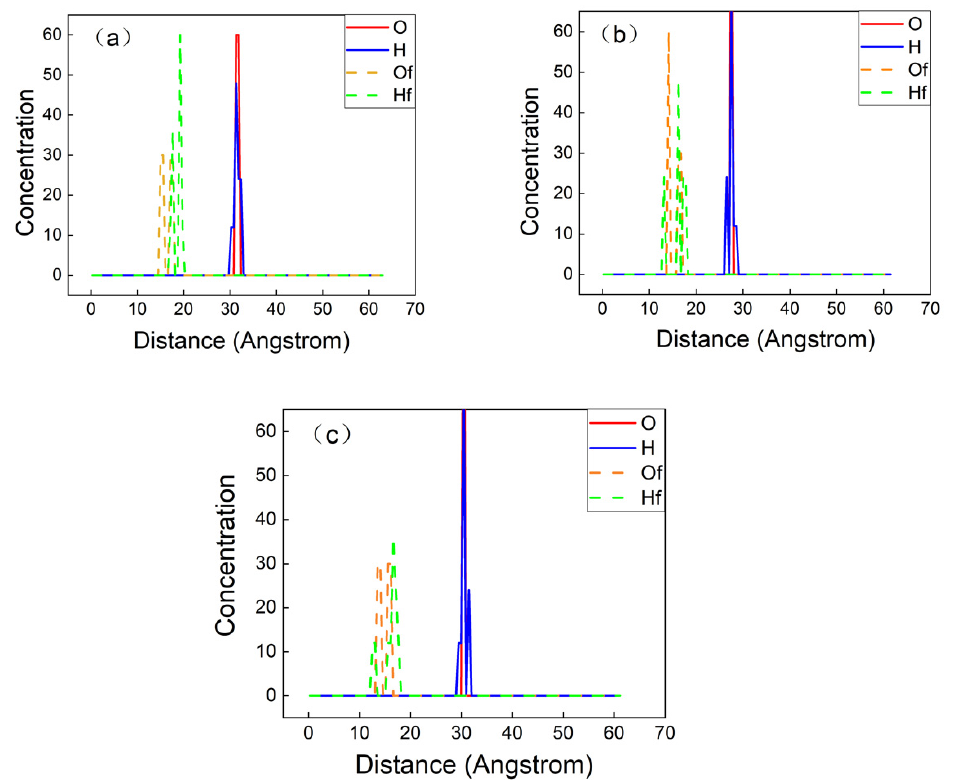
Figure 13. Concentration profiles of oxygen (O) and hydrogen (H) atoms in PET on top of ( a ) Cr 2 O 3 (110), ( b ) Cr 2 O 3 (200), and ( c ) Cr 2 O 3 (211) surfaces before (O and H) and after (Of and Hf) MD simulations.